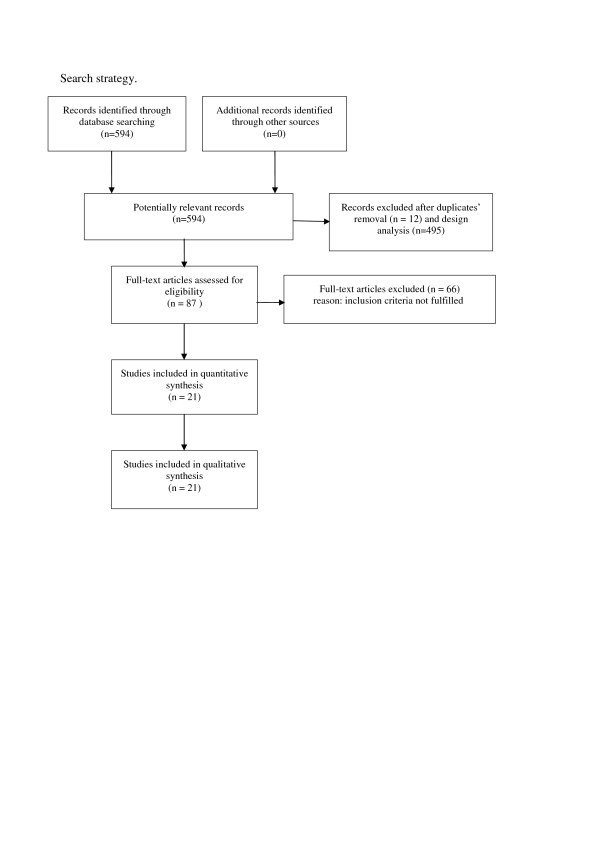
Search strategy.